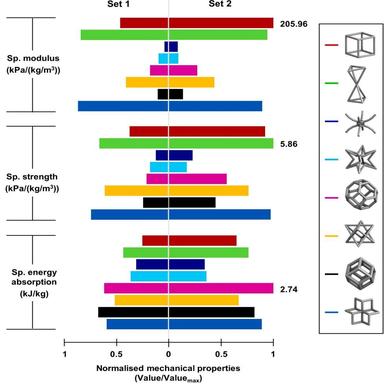
Comparison of the mechanical performance of different lattice structures. Only the highest value of each parameter is given in the figure. The multiplication of the highest value and the normalised value from the abscissa will give the other values. It should be noted that both values of auxetic structure in Sets 1 and 2 for each parameter are the same due to the common structure of auxetic unit cell topology used in both sets.